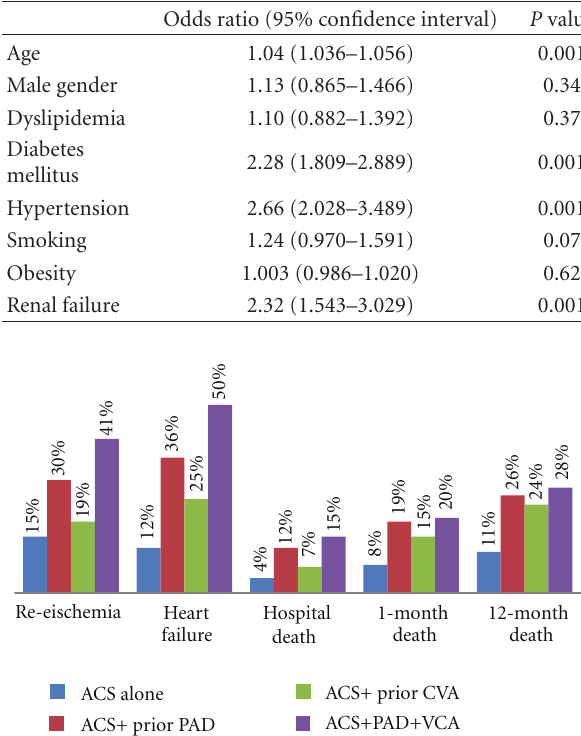
Figure 1: Clinical outcomes in di ff erent vascular disease combina- tions ( P = 0 . 001 for all comparisons).